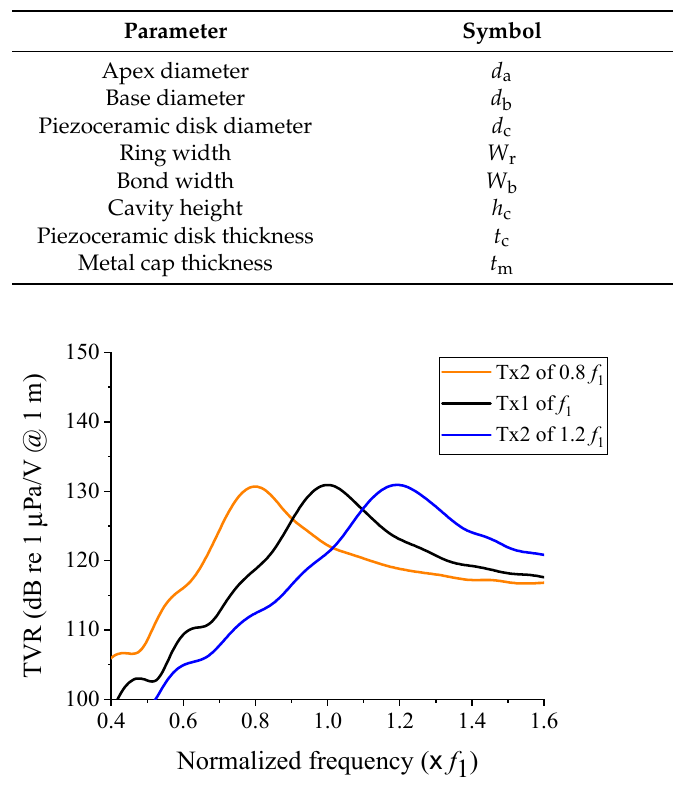
Figure 2. Underwater TVR spectra of the designed Tx 1 and two Tx 2 transducers.